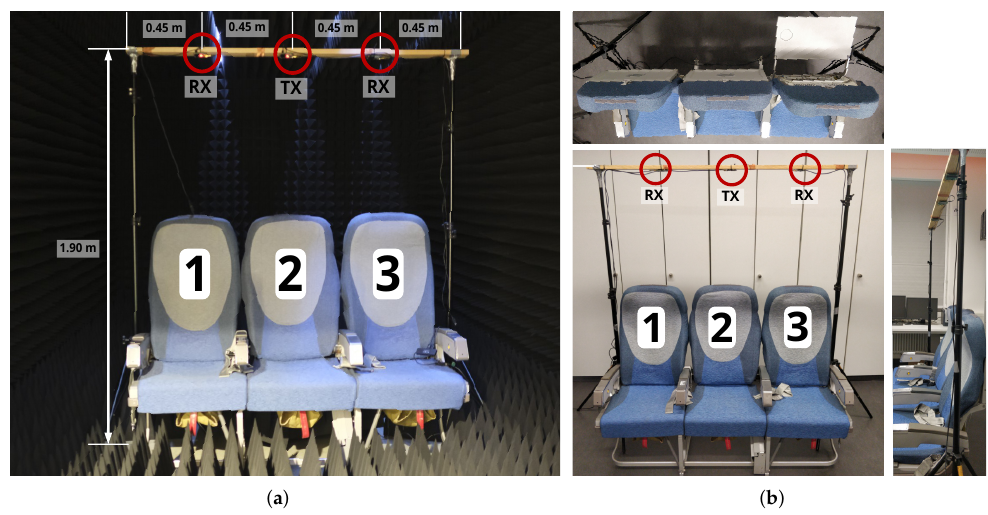
Figure 11. Measurement setup with one transmitter and two receivers: ( a ) in the RF anechoic chamber and ( b ) in the lab mockup. Applied seat/table numbering is also indicated.